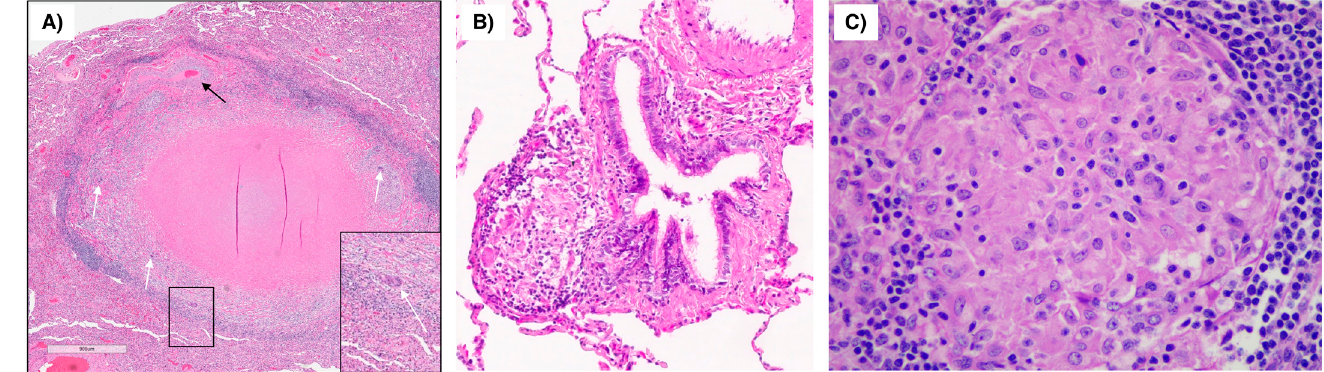
Figure 1. Pulmonary granuloma due to mycobacteria vs. sarcoidosis. ( A ) Granuloma with central necrosis surrounded by epithelioid histiocytes, multinucleated giant cells (white arrows) and fibrosis in the resected left lower lobe of a patient with Mycobacterium avium complex lung disease. Note the adjacent pulmonary artery (thin black arrow). Inset shows a magnified multinucleated giant cell. ( A ) is modified from Schenkel AR et al. [23] Immune Netw 2022. ( B ) Sarcoid granuloma (arrow) next to a medium size ciliated bronchus. ( C ) Magnified view of another sarcoid granuloma. ( B , C ) are courtesy of Carlyne Cool, MD, National Jewish